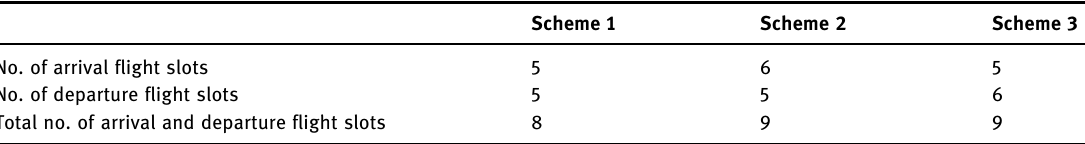
Table 2: Schemes for the number of fl ight slots that can be allocated within 15